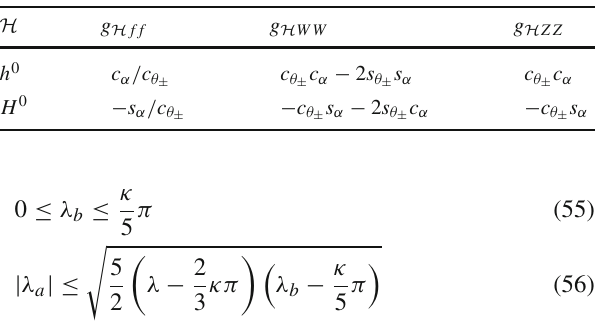
Table 1 The CP-even neutral Higgs couplings to fermions and gauge bosons in the HTM0 relative to the SM Higgs couplings. α and θ ± are the mixing angles respectively in the CP-even and charged Higgs